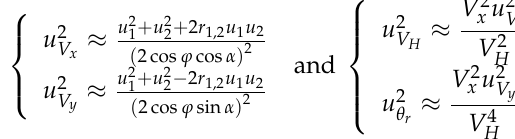
Table 2. Scale analysis of uncertainty components contributing to uncertainties on V x V y , V H and θ r . Combined Uncertainty Uncertainty Term and Order of